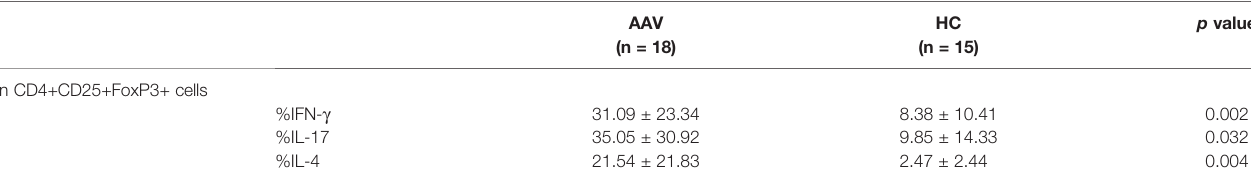
TABLE 2 | Frequencies of intracellular cytokines in Tregs in patients with AAV and healthy controls.